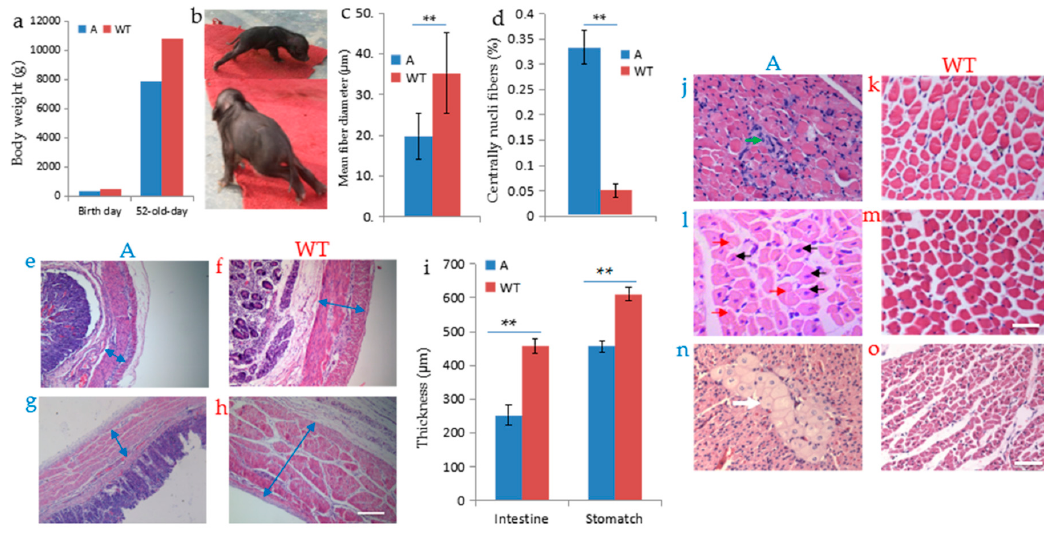
Figure 5. DMD deficiency resulted in pathological alterations in the DMD -modified pig. ( a ) The birth weight (480 g) and body weight at 52 days (7809 g) of founder A were lower than that of the wild-type piglet (birth weight 575 g and body weight at 52 days was 110,200 g); ( b ) Behavioral performance of muscle weakness of founder A; ( c ) Mean minimal Feret’s diameter of muscle fibers in biceps femoris muscle of 52-day-old founder A and WT; ( d ) Proportion of muscle fibers with central nuclei in deltoid muscle of 52-day-old founder A and WT. ** p < 0.01; ( e – h , j – o ) Haematoxylin and eosin (H&E) staining, paraffin section; ( e – i ) Smooth muscle thickness of stomach ( e ) and intestine ( g ) were dramatically decreased compared with that of WT ( f , h ). Blue arrows indicate the thickness of stomach and intestine; ( j ) Cross-section of biceps femoris muscle revealed disordered myofiber construction and the green arrow indicated the aggregated nuclei; ( l ) Black arrows indicated the rounded myofibers with central nuclei, and red arrows indicated the necrosis of myofibers in deltoid muscle; ( n ) Multifocal area of pale discoloration in cardiac muscle was observed in section; ( k , m , o ) histological section of skeletal muscle and cardiac muscle of wild-type. Scale bars: 50 µm ( e – h , j – m ),100 µm ( n , o ).